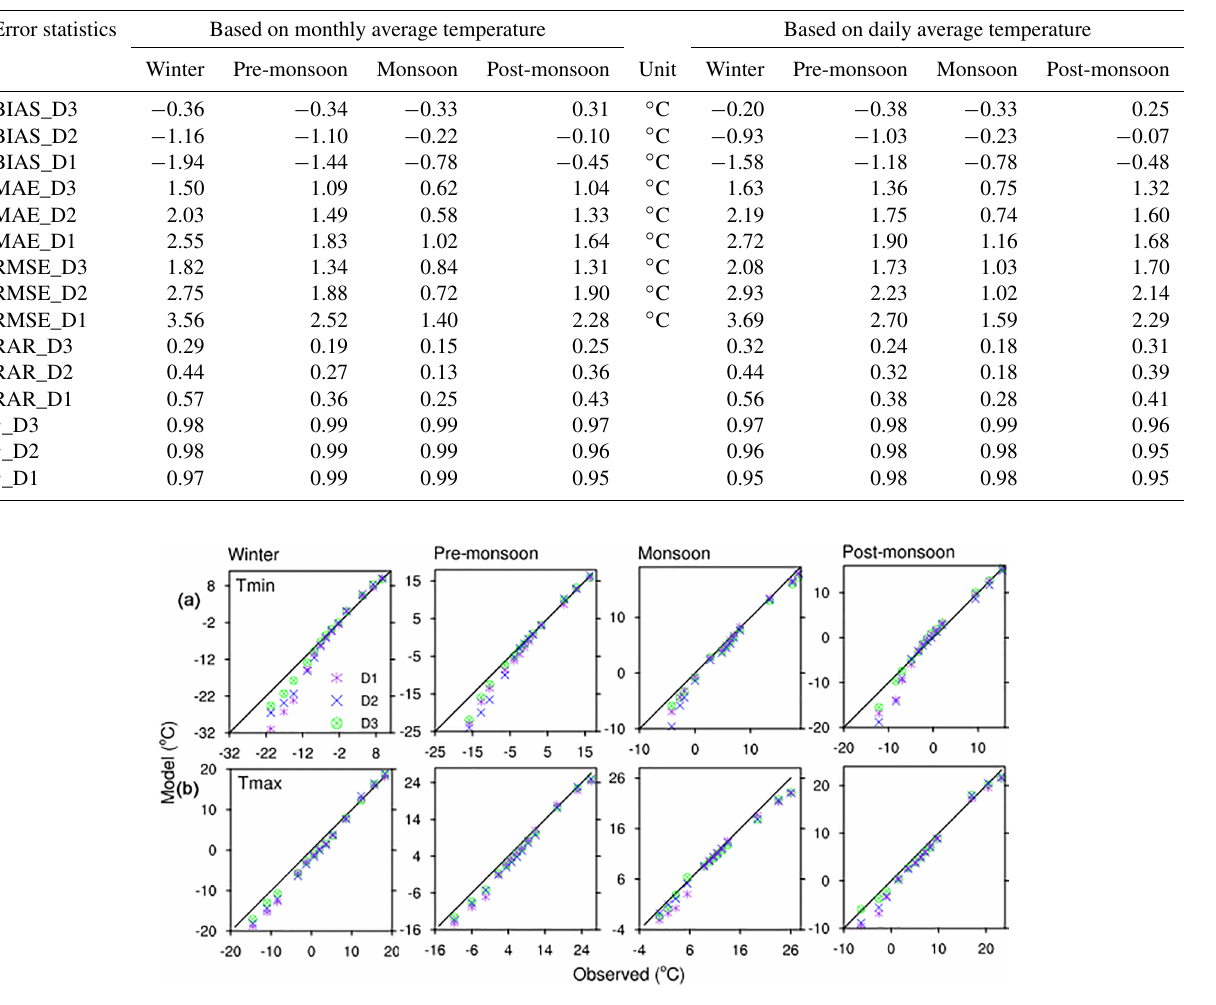
Figure 7. Percentile value comparison for daily minimum (Tmin, a ) and maximum temperature (Tmax, b ) (1, 5, 10, 20, 30, 40, 50, 60, 70, 80, 90, 95, and 99 percentiles) at three WRF resolutions with observations for four different seasons.